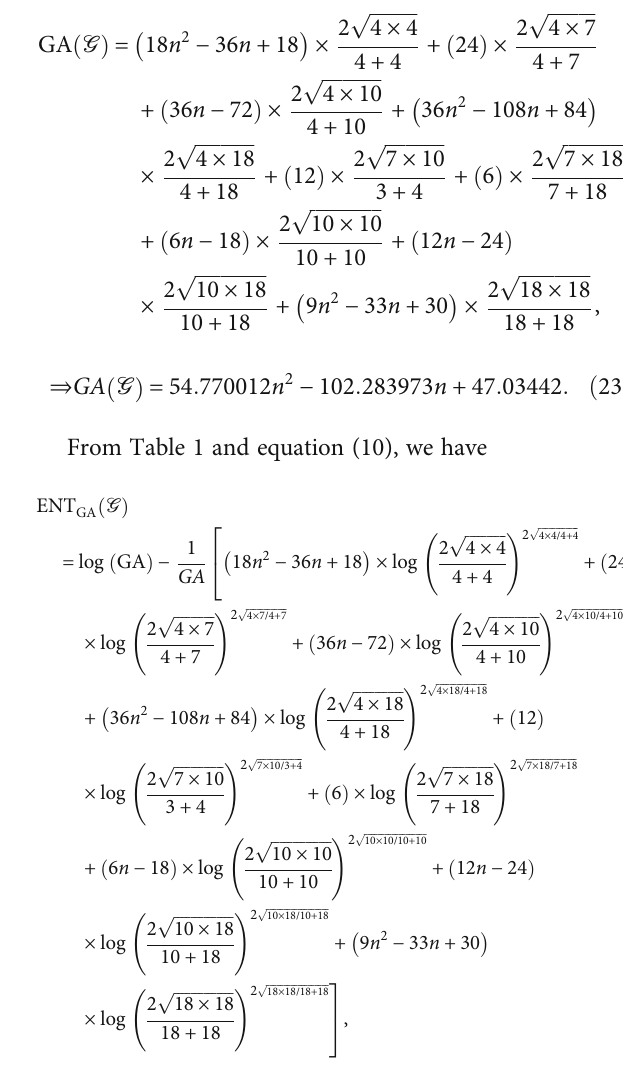
Figure 5: Randic ’ entropy for α = 1/2 Table 1 and equation (5), GA index is